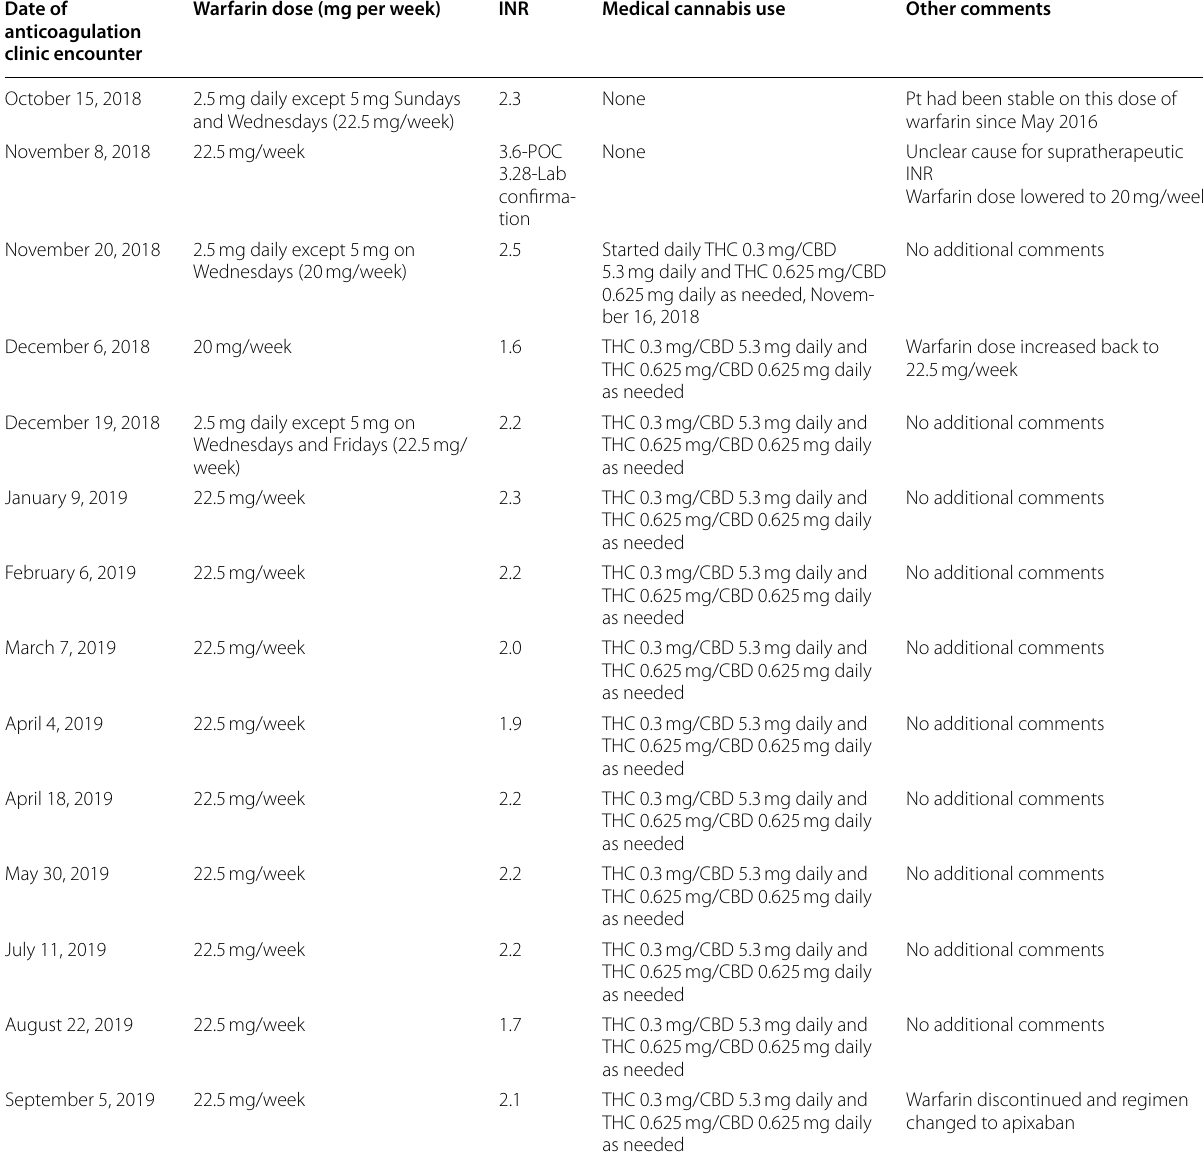
Table 1 Warfarin dosing, INR, and medical cannabis history